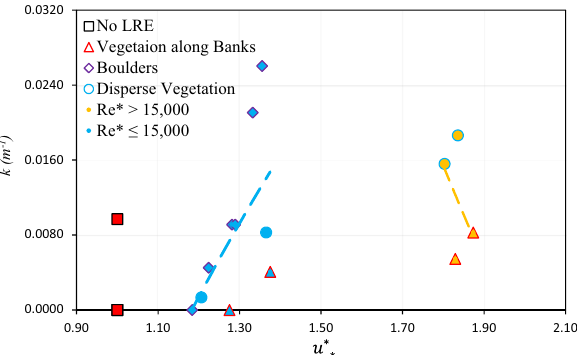
u and retention coefficient (k). (The red ∗ (cid:31) ∗ (cid:30)